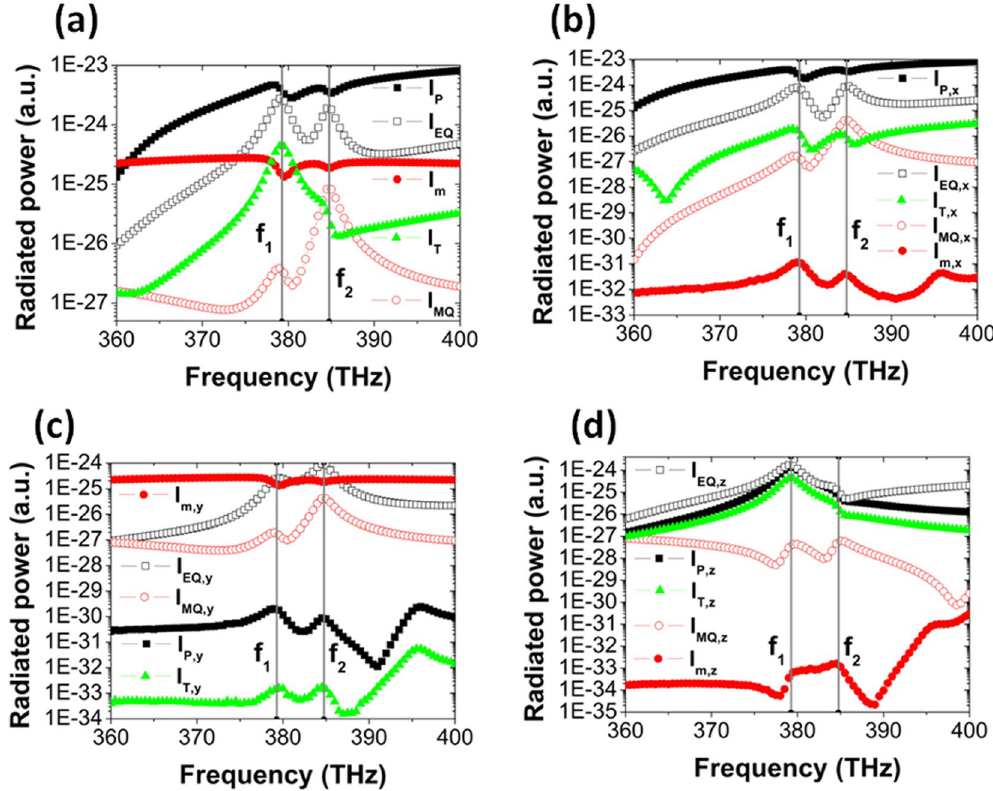
Figure 3. ( a ) Radiated power from electric dipolar moment ( I p , solid black square), magnetic dipolar moment ( I m , solid red circle), electric quadrupole dipolar moment ( I EQ , hollow black square), magnetic quadrupole dipolar moment ( I MQ , hollow red circle), and toroidal dipolar mement ( I T , green triangle). ( b , c ) The same as ( a ) but for x , y and z components of radiated power, respectively. Two vertical gray lines label the resonance frequencies of f 1 and f 2 in Fig.